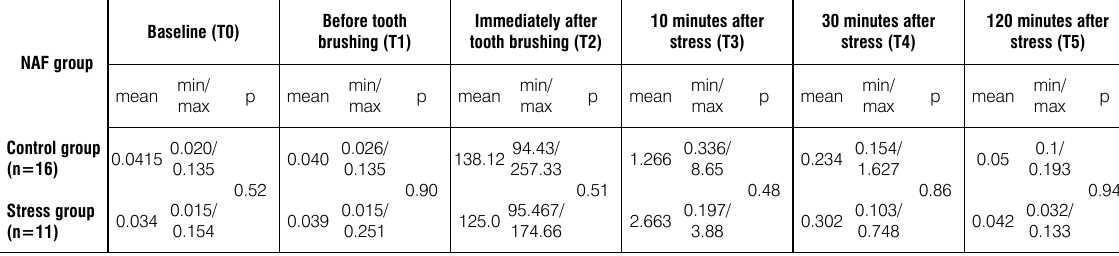
Table 2. Saliva fluoride concentration in the NaF control and NaF stress